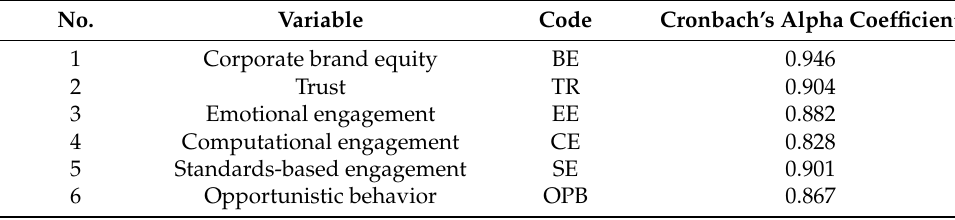
Table 2. Assess the reliability of the scale through Cronbach’s Alpha coefficient.